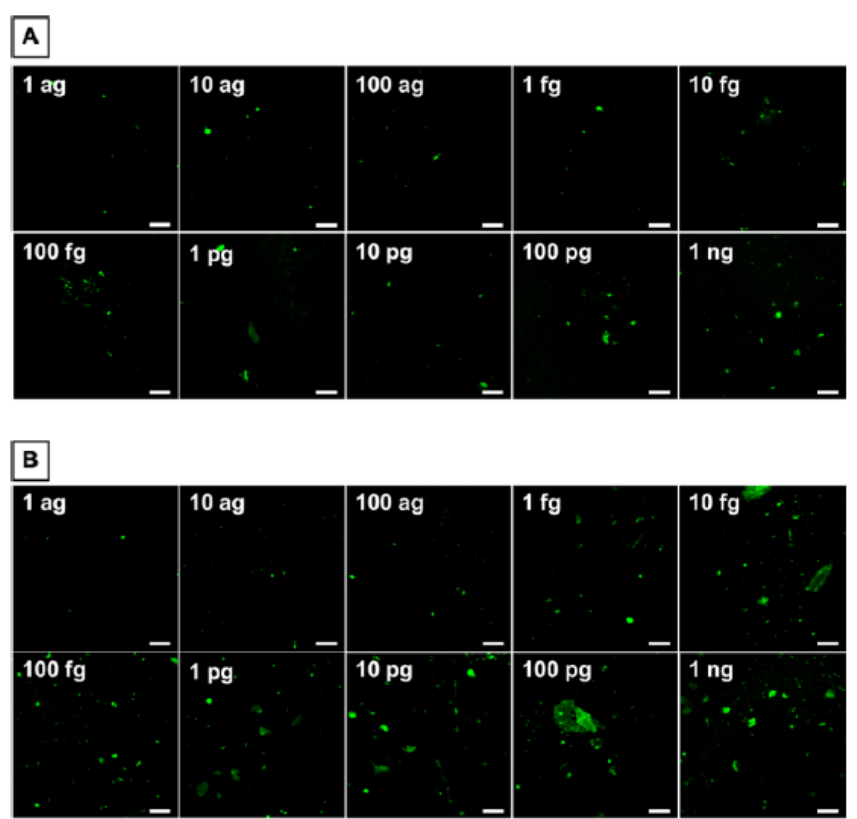
Figure 13. Confocal images of an electrode modified with 16-mercaptohexadecanoic acid and the in-house-generated mAb20B3 ( A ) and a commercially available Hytest mAb228 primary antibody ( B ), following exposure to the cTnI target (1 ag/mL to 1 ng/mL) and the Ir(III)-labeled commercial secondary antibody (mAb19C7). Luminescence images were recorded live on a Zeiss LSM510 Meta confocal microscope using a 40× oil immersion objective lens (NA 1.4) and a 488 nm argon ion laser applied for iridium-labeled antibody imaging. Scale bar 20 μ m. Reproduced with permission from [83].